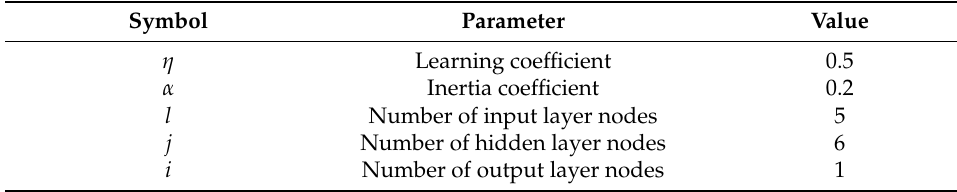
Table 2. Parameters of the IMCPIDNN